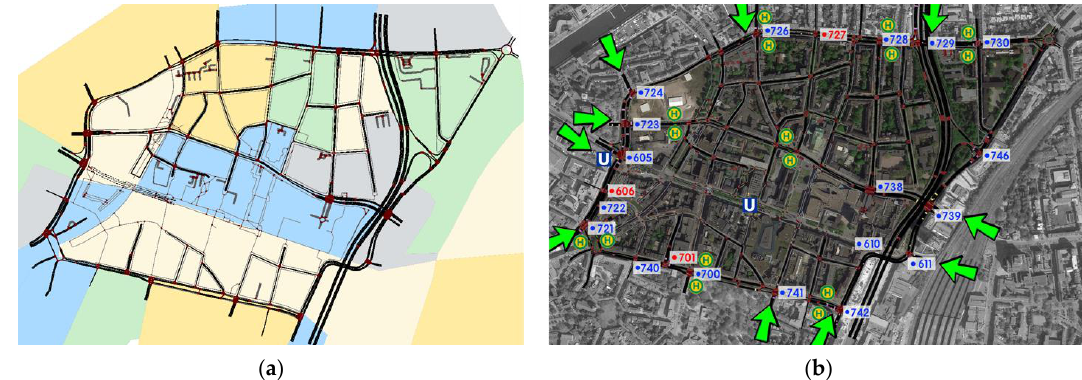
Figure 2. Two data sources of traffic demand (( a ) Origin–Destination (OD) matrix, where the distribution of OD areas is shown in different colors; ( b ) induction loops, where the numbers are intersections of the inner ring area).